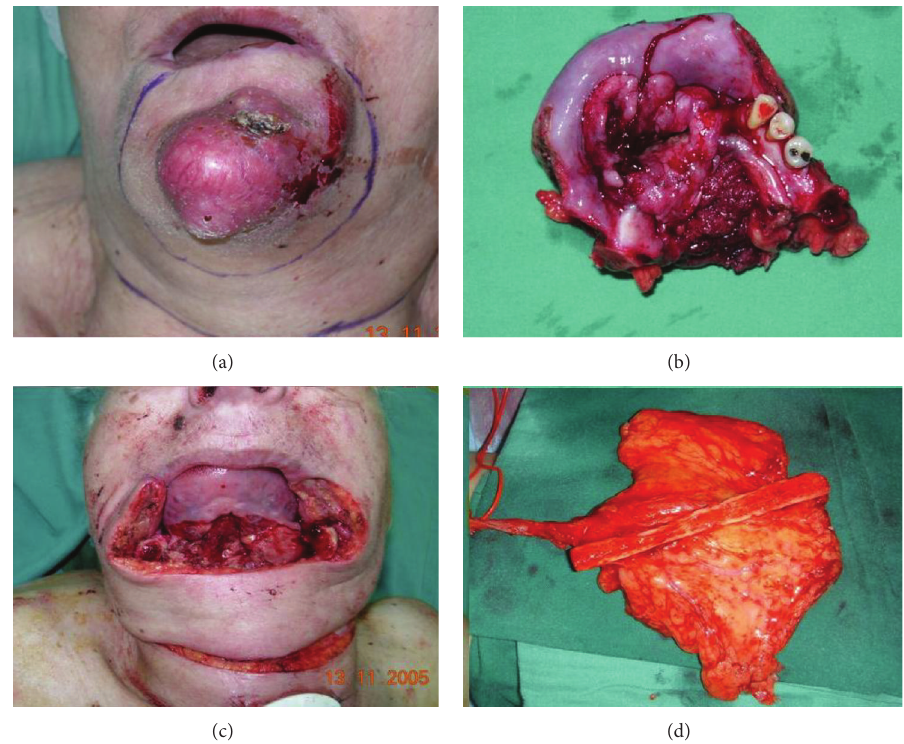
Figure 2: Patient number 2. (a) Tumor involving lower lip, chin, anterior segment of Mandible and flour of mouth. (b) Tumor resected. (c) Resulting defect (d) Flap elevated with a segment of radius bone attached thru periosteum to thevascular pedicle.